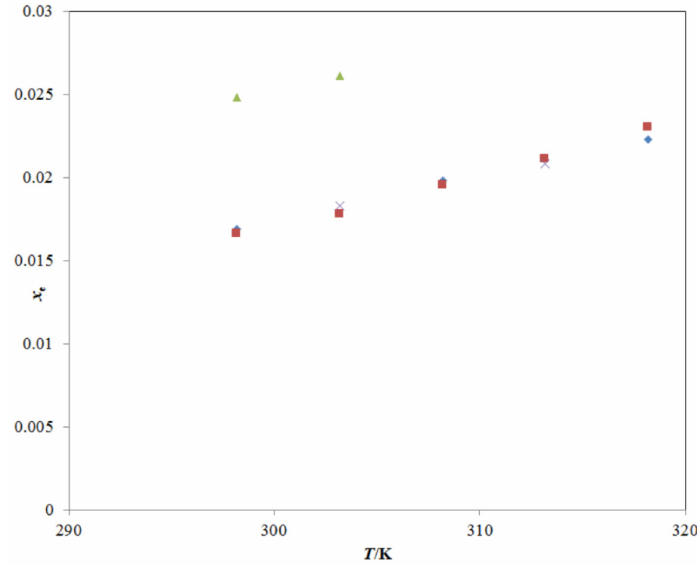
Figure 2. A graphical comparison of TRV solubility in neat water with reported values at different